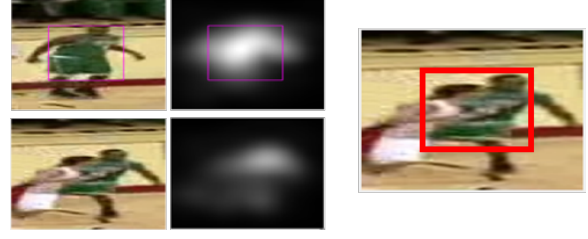
Figure 10. Illustration of the occlusion